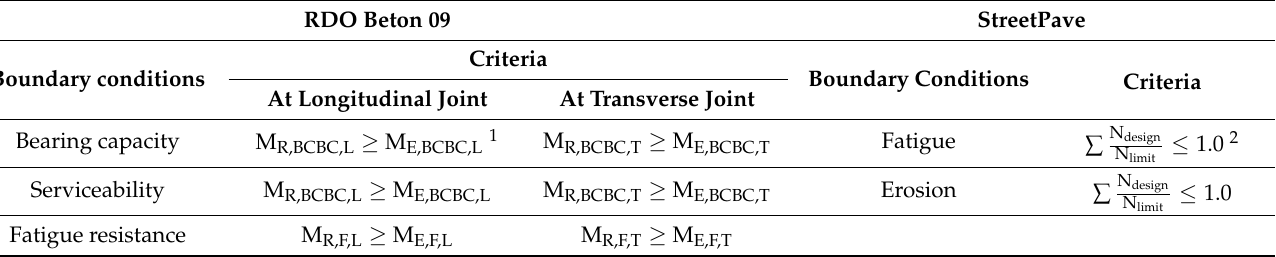
Table 2. Design criteria for RDO Beton 09 method and design software